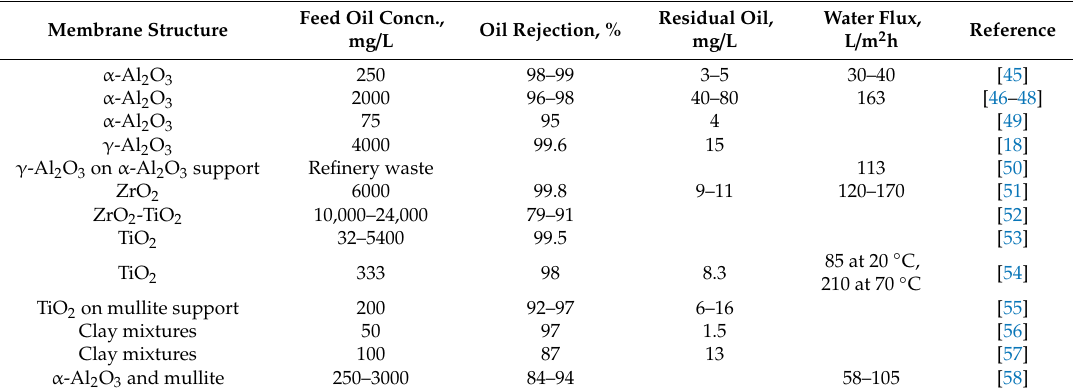
Table 2. Oil removal results using inorganic